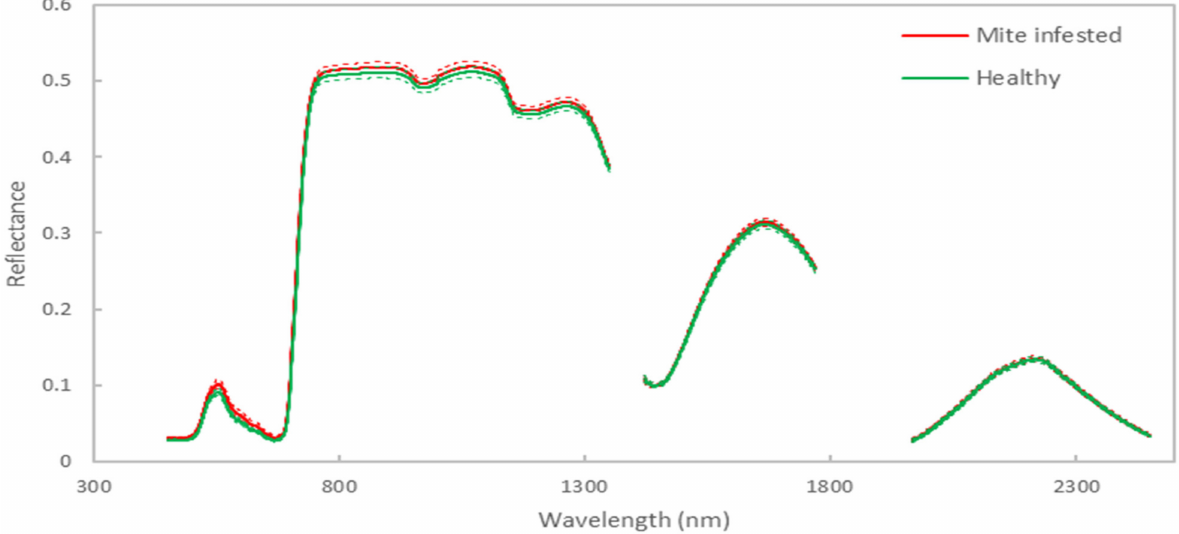
Figure 4. Averaged reflectance spectra for healthy banana plants and mite-infested banana plants gathered from mite outbreaks at the University of Queensland glasshouses on 1 November 2017, 17 December 2017 and 9 January 2018. Solid lines indicate the average and dash lines indicate ± standard